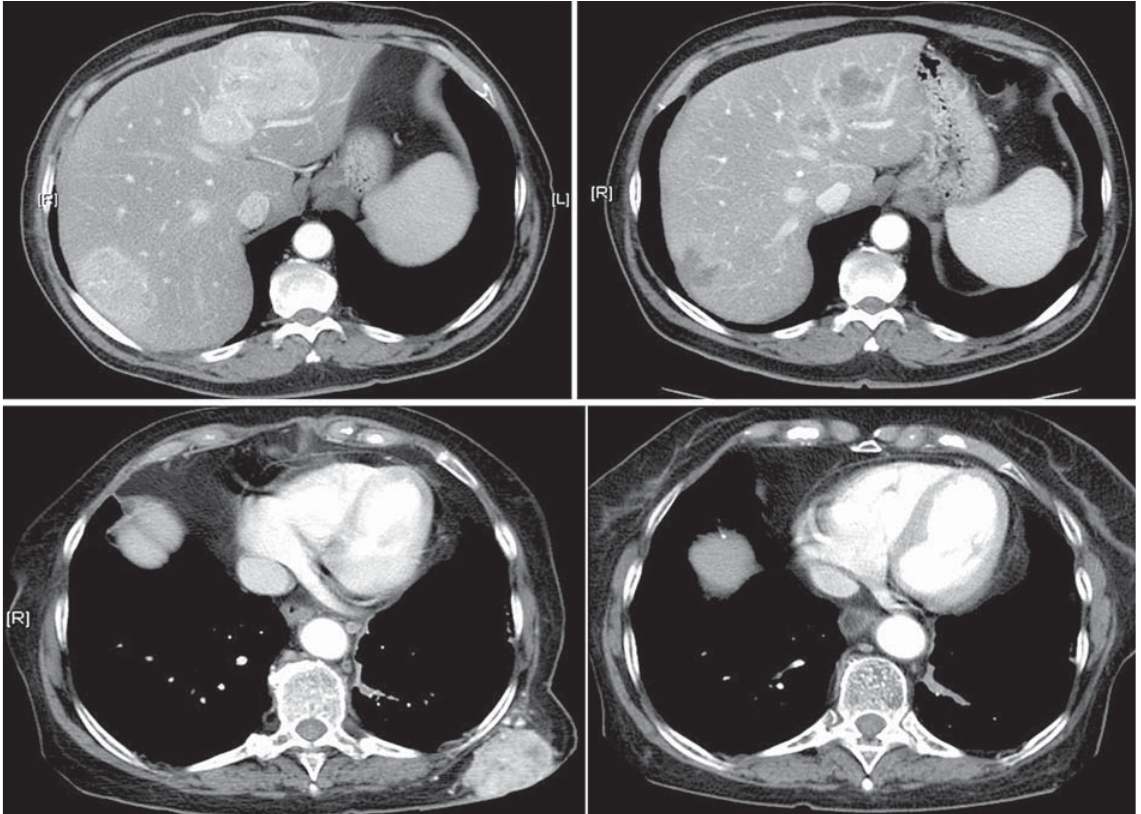
Figure 2 – Axial CT image showing examples of partial response of a renal cell carcinoma metastases in liver and